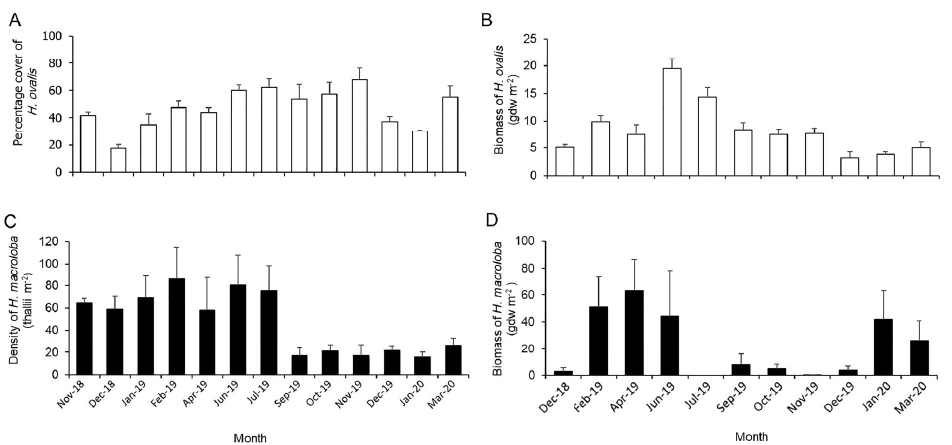
Figure 2. Abundance of macrophyte (mean ± SE) from November 2018 to March 2020 except March, May, and August 2019, and February 2020, and biomass of macrophytes (mean ± SE) from December 2018 to March 2020 except January, March, May, and August 2019, and February 2020: ( A ) percentage cover of H. ovalis in seagrass habitat; ( B ) aboveground biomass of H. ovalis in seagrass habitat; ( C ) density of H. macroloba in seaweed habitat and ( D ) aboveground biomass of H. macroloba in seaweed habitat.